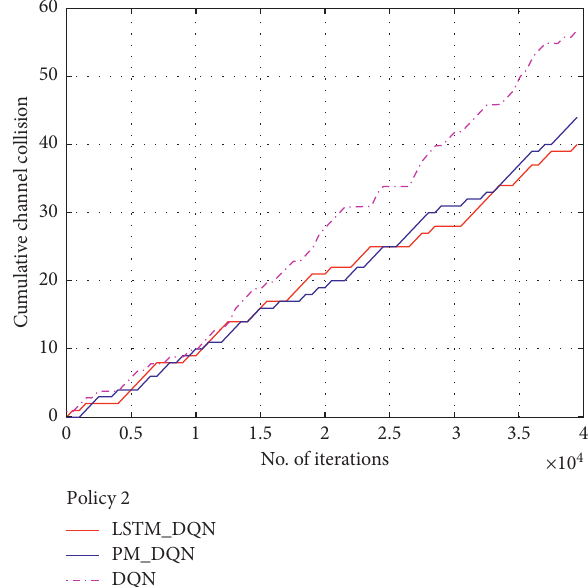
Figure 13: Relationship between the number of iterations and channel collision (policy 2).